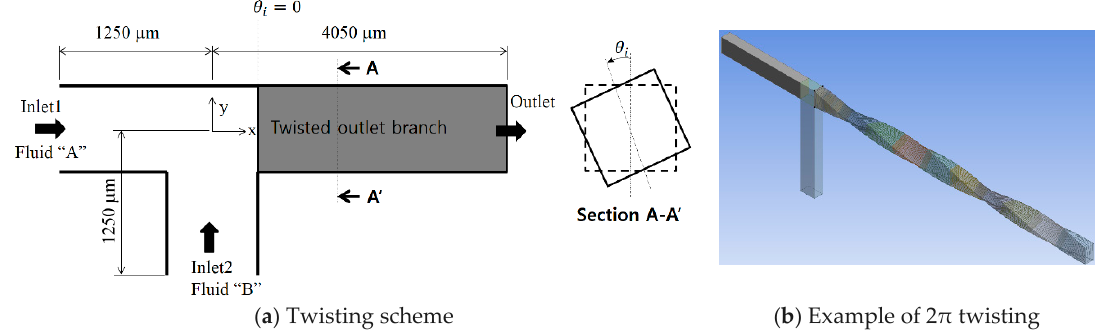
Figure 1. Diagram of a T-shaped micro-channel with twisting.